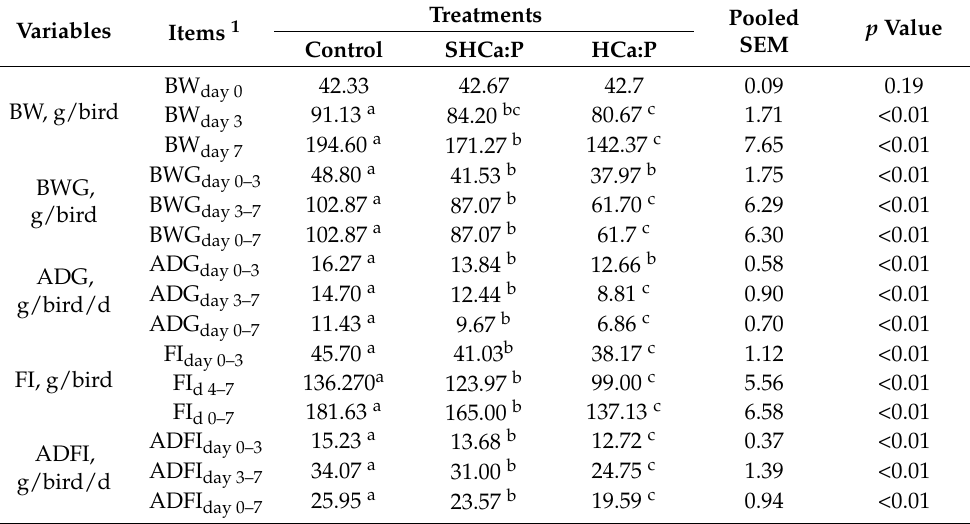
Table 5. Effect of high-calcium (Ca): phosphorus (P) ratio, P-deficient (HCa:P) crumbled feed on growth performance in 0- to 7- day-old broiler chicks during trial